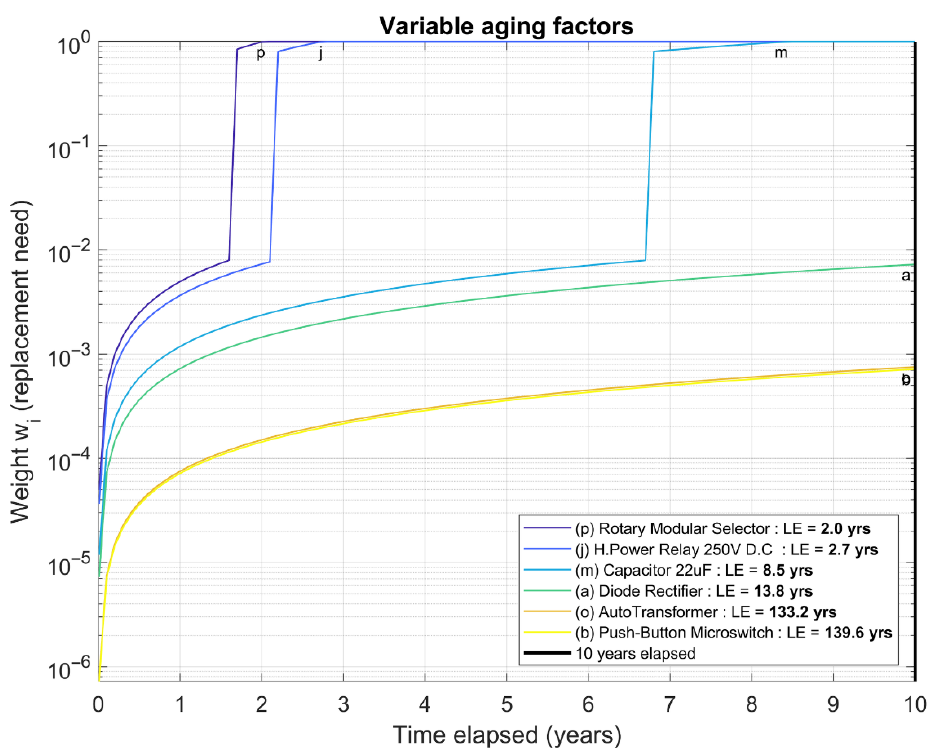
Figure 6. Weight of components to be replaced versus time elapsed for a dishwasher’s PCB.